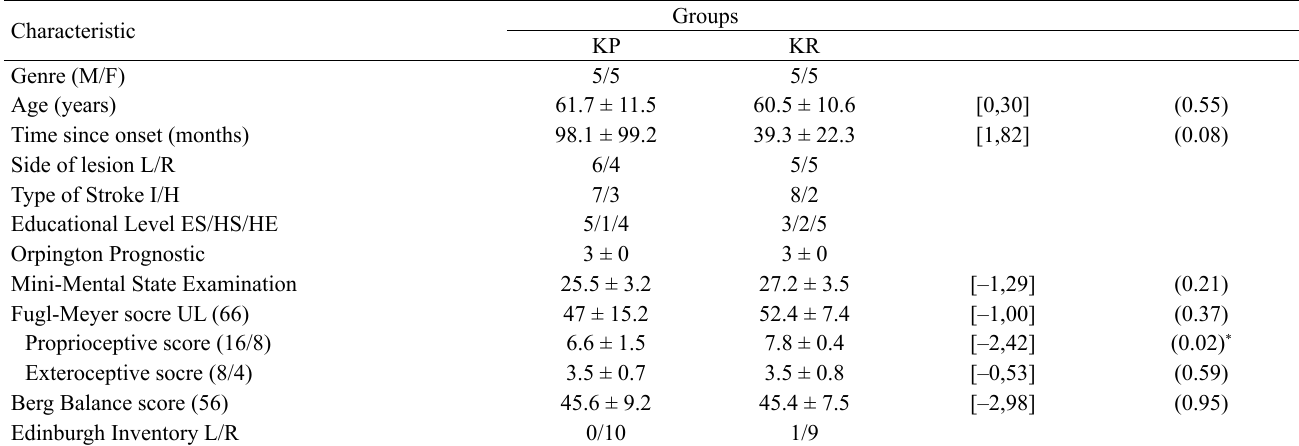
Table 1: Demographic and clinical data of the experimental groups.